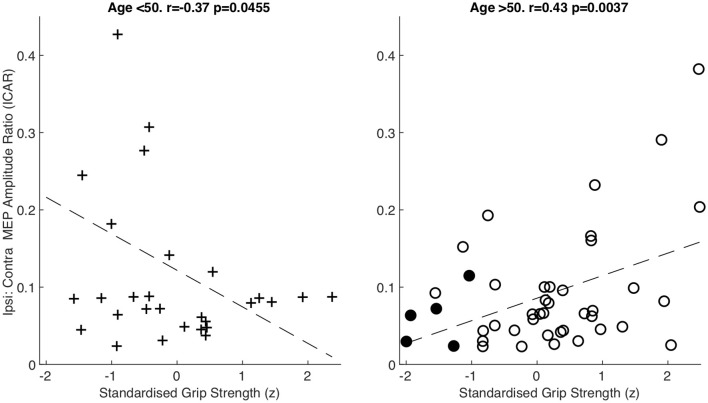
Amplitude ratio (ICAR) compared to standardized grip strength in both age groups. Sarcopenic patients are highlighted with filled circles.